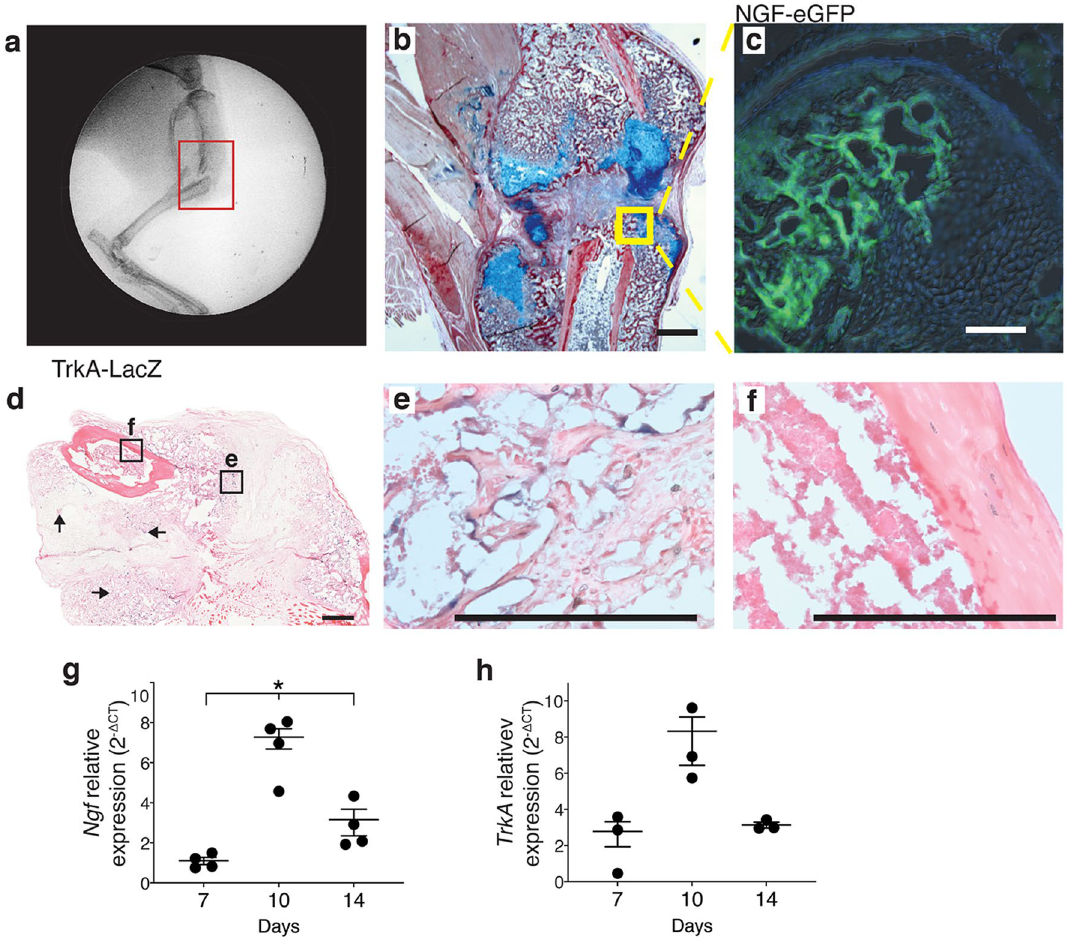
Figure 1. Endogenous expression of Nerve growth factor (NGF) and its receptor Tropomyosin receptor kinase A (TRKA) within fracture callus during endochondral repair. ( a ) A gross fluoroscope image of the entire tibia with the red frame indicating the mid diaphyseal, unstabilized bone fracture. ( b ) Representative image of HBQ stained section of tibia fracture callus 14 days post-fracture (p.f.), (n = 4). Scale bar: 1 mm ( c ) Fluorescence image NGF-eGFP with DAPI of chondro-osseous transition zone (TZ) 14 days p.f. (n = 4). Scale bar: 200 μm. ( d ) Brightfield image of X-GAL stained callus 14 days p.f. (n = 4). Arrows indicate additional areas of LACZ + cells within callus. Scale bar: 500 μm ( e ) Higher magnification image of TZ within fracture callus. ( f ) Higher magnification image of cortical bone shows no staining. ( e , f ) Scale bars: 200 μm ( g ) Relative expression (2 -ΔCT ) normalized to Gapdh of Ngf and ( h ) TrkA harvested from fracture callus at 7, 10, and 14 days p.f. Error bars represent SEM. *p < 0.05; determined by one-way ANOVA with Tukey’s multiple comparison